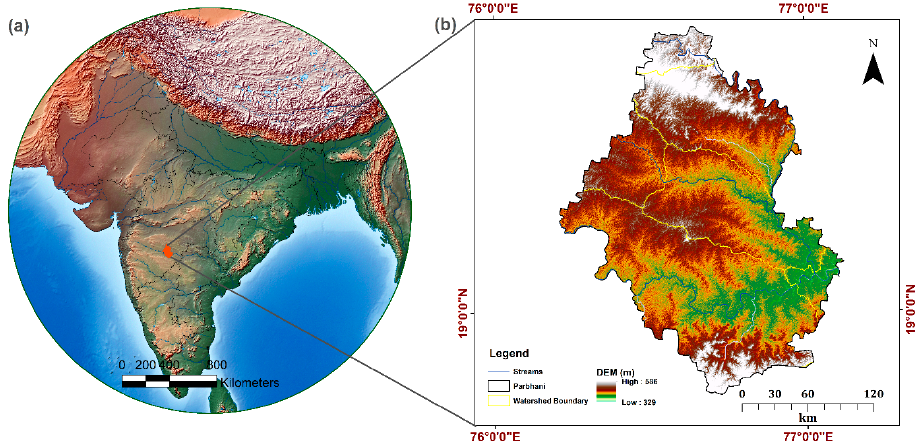
Figure 1. The study area: ( a ) its location in India, ( b ) Parbhani district.